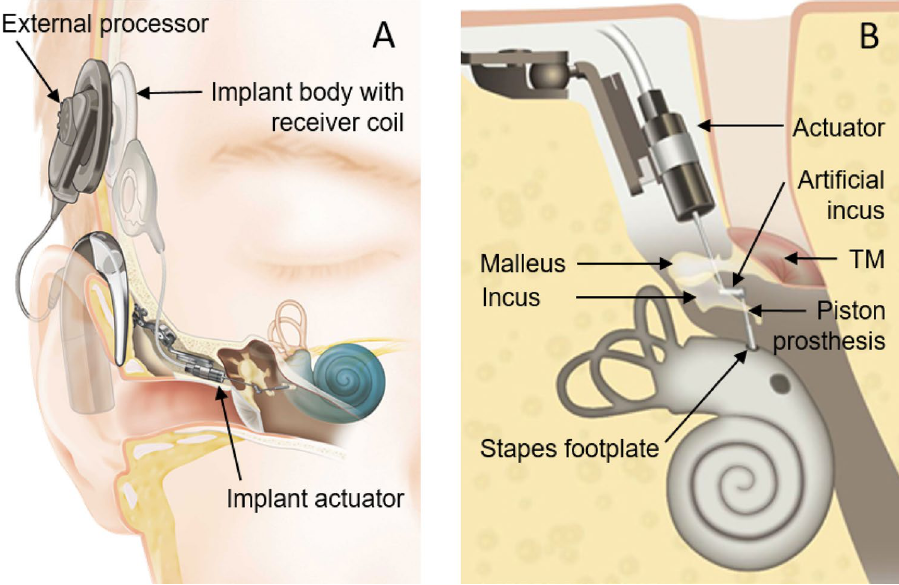
Figure 1. ( A ) Schematic of the Codacs direct acoustic cochlear stimulator consisting of an implant body with receiver coil, an actuator and an external processor stimulating the inner ear ( B ) actuator with artificial incus driving a piston prosthesis through a stapedotomy (image courtesy of Cochlear ltd.). TM tympanic membrane.